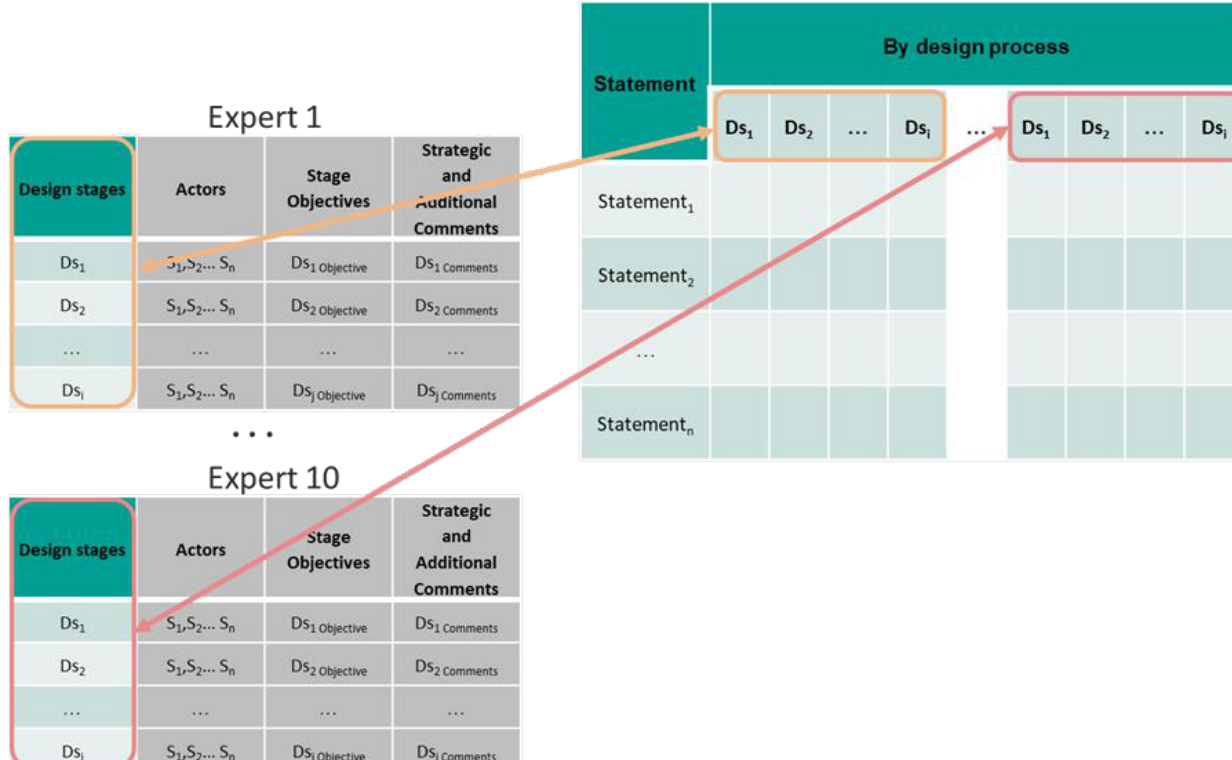
Figure 4. Multi-expert data compilation regarding the elements of the design process axis.